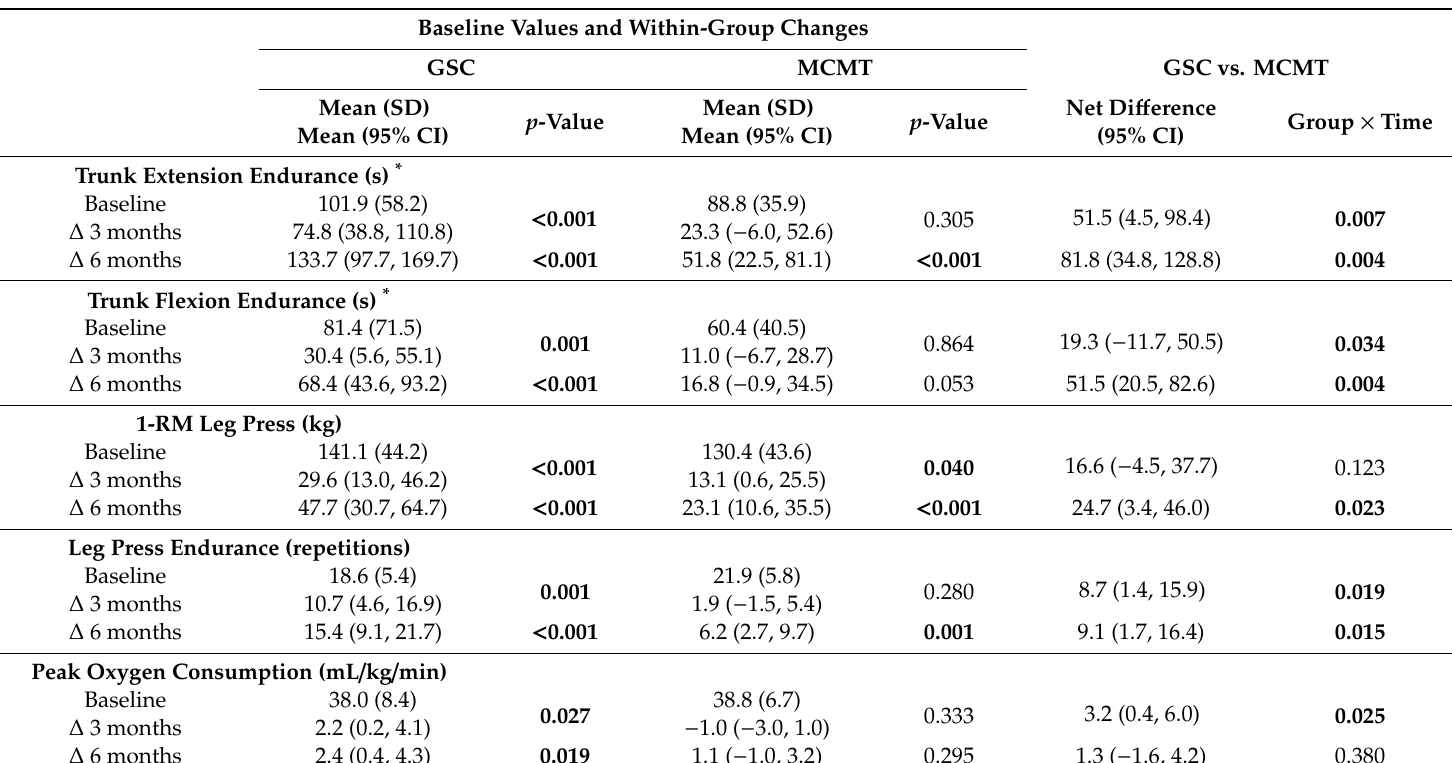
Table 2. Intent-to-treat analysis using linear mixed models on physical outcomes at baseline, three and six months in participants randomized to general strength and conditioning (GSC) and motor control manual therapy